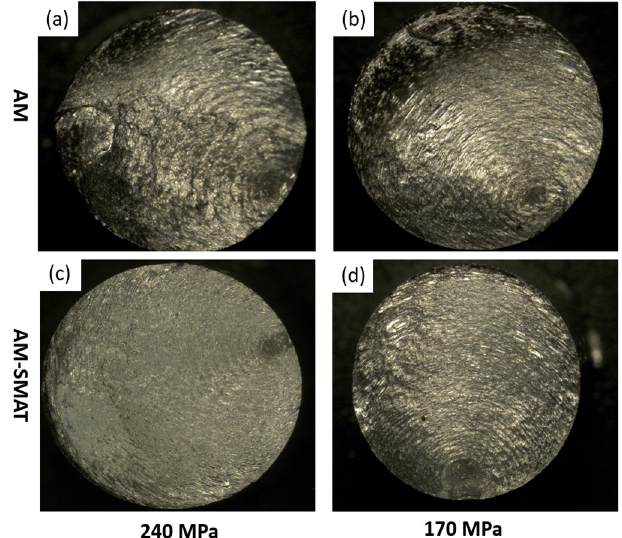
Figure 4. Macro-failure analyses of fracture surfaces: ( a , b ) correspond to AM state under 240 MPa and 170 MPa, respectively; ( c , d ) correspond to AM-SMAT state under 240 MPa and 170 MPa, respectively. Note that the diameter of the fracture surfaces is about 4 mm.